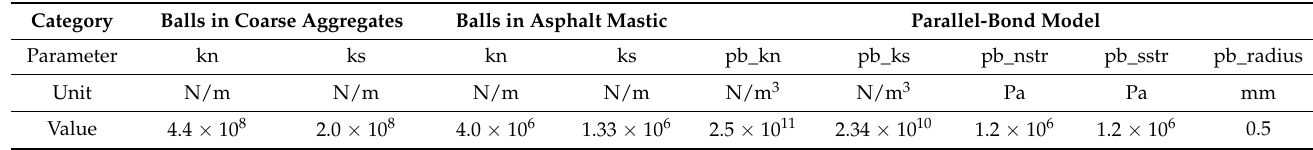
Table 3. Mesoscopic parameters of the balls and parallel-bond model.